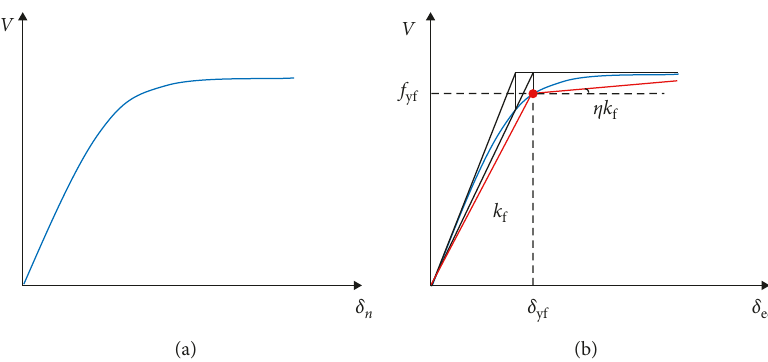
Figure 6: Nonlinear parameters of the frame. (a) Capacity curve of the frame. (b) Force vs. displacement curve of the equivalent SDOF system.